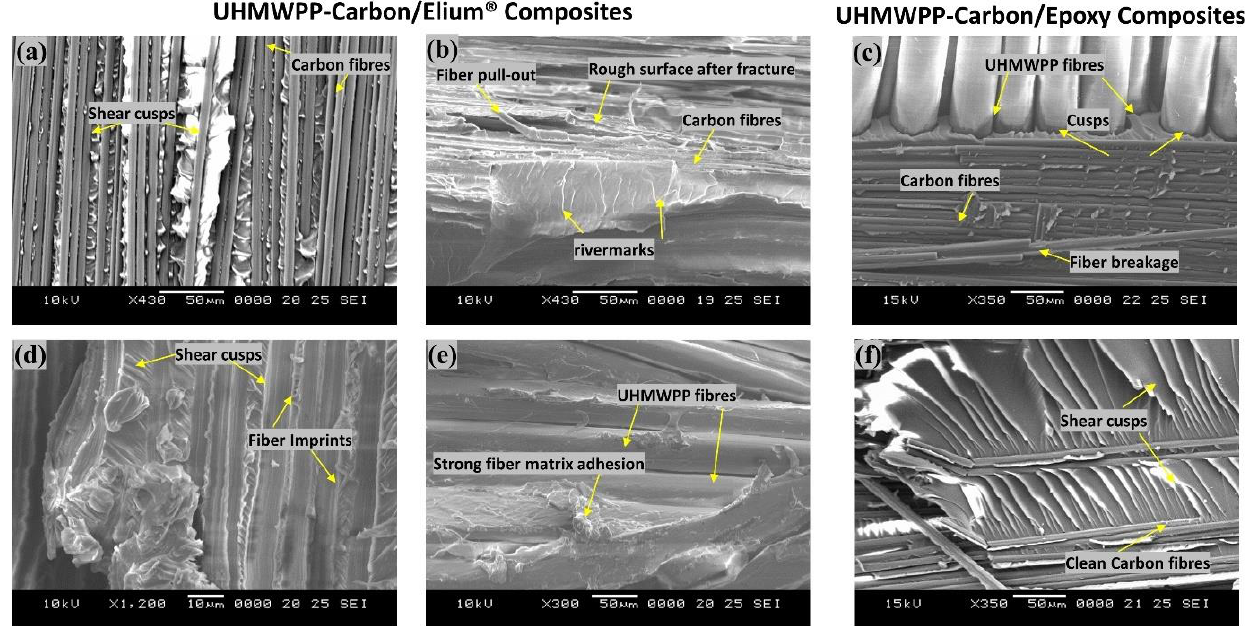
Figure 20 . Surface morphological images of fractured surfaces of composites using Scanning Elec- Figure 20. Surface morphological images of fractured surfaces of composites using Scan- tron Microscopic approach of ( a , b , d , e ) Carbon_UHMWPP/ Elium ® composite ( c , f ) Car- ning Electron Microscopic approach of ( a , b , d , e ) Carbon_UHMWPP/Elium ® composite ( c , f ) Car- bon_UHMWPP / Epoxy composite under Mode II loading . bon_UHMWPP/Epoxy composite under Mode II